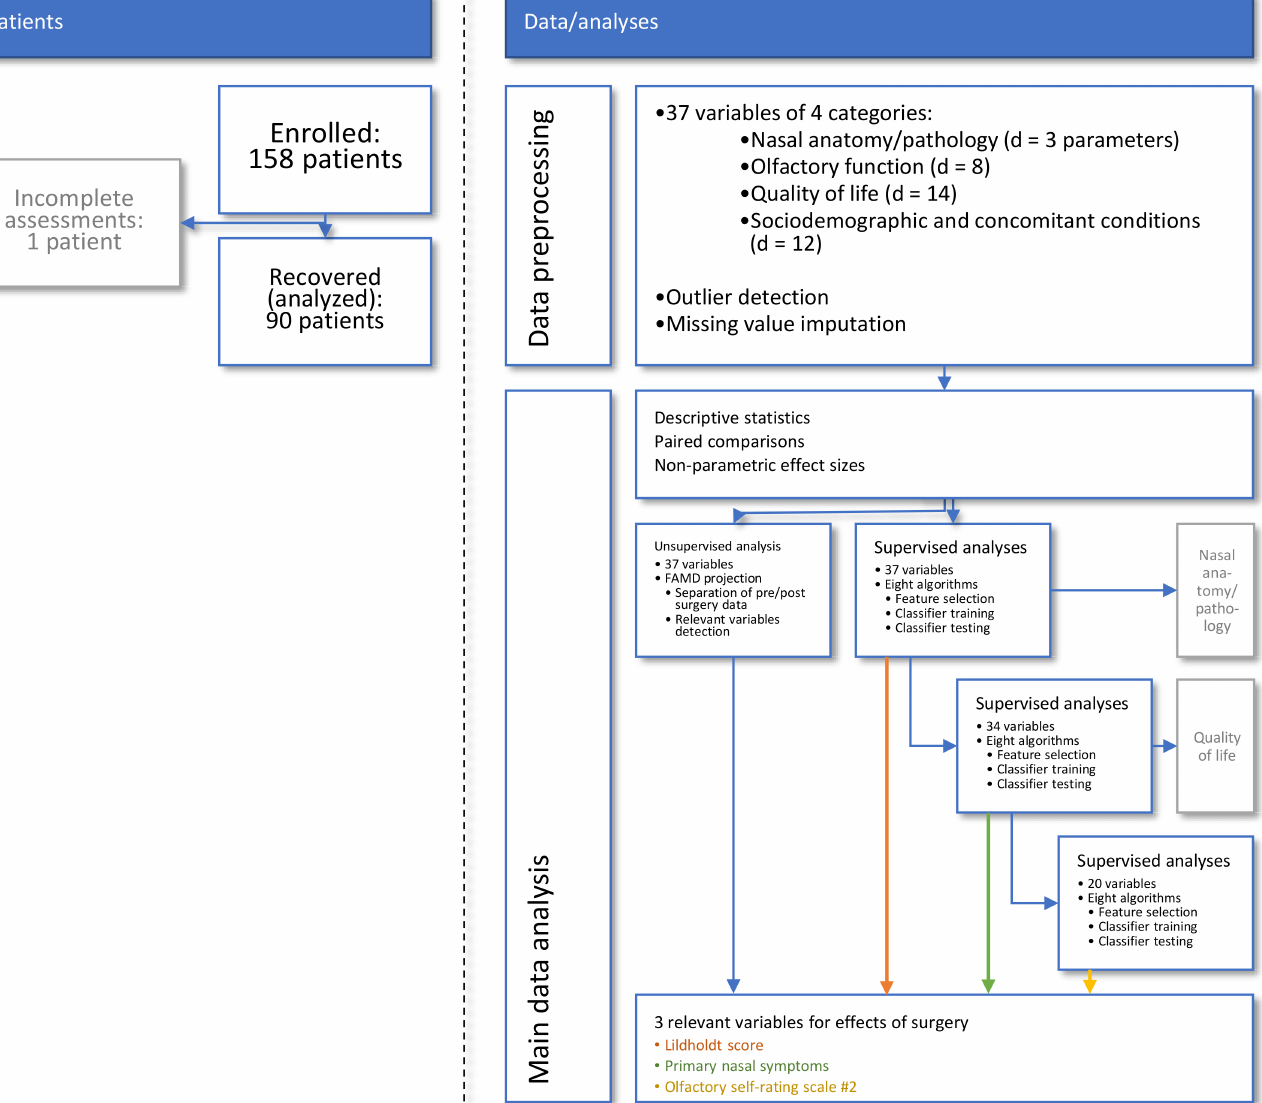
Figure 1. Flow chart showing the number of patients and data analysis steps. Major steps in data analysis reached from preprocessing to unsupervised and supervised analyses until variables relevant to capturing the effect of endoscopic endonasal surgery were identified and internally validated. The figure has been created using Microsoft PowerPoint ® (Redmond, WA, USA) on Microsoft Windows 11 running in a virtual machine powered by VirtualBox 6.1 (Oracle Corporation, Austin, TX,